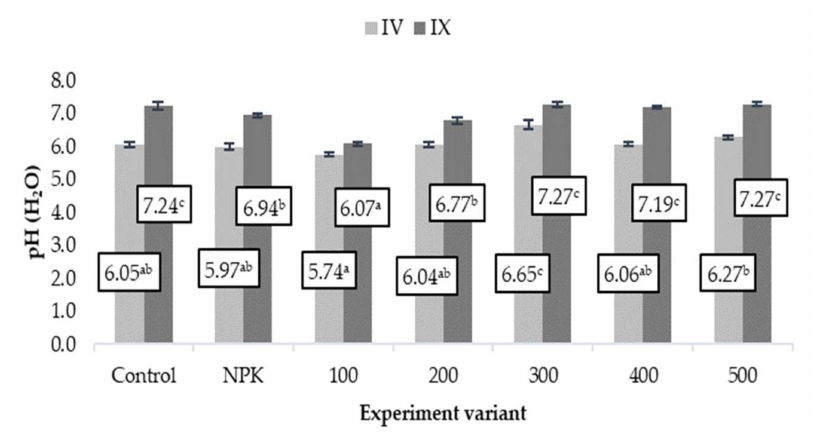
Figure 1. Changes in the pH of the podzolic soil in the 0–5 cm layer in IV (April) and IX (September) 2021 after the application of biomass combustion ashes (mean ± SD). Treatments not sharing the same letter(s) are statistically significant at p < 0.05 (Tukey’s HSD).